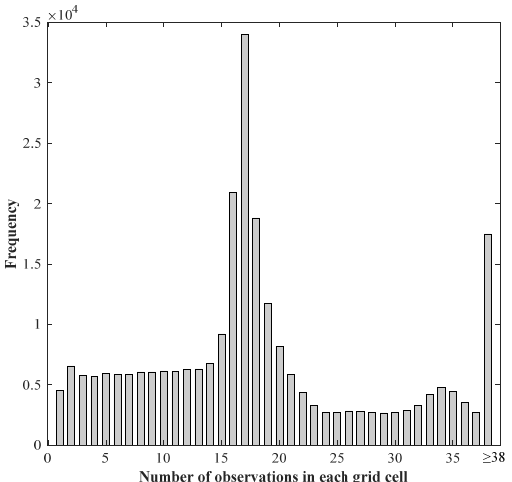
Figure 1. Frequencies of the numbers of observations in each grid cell.